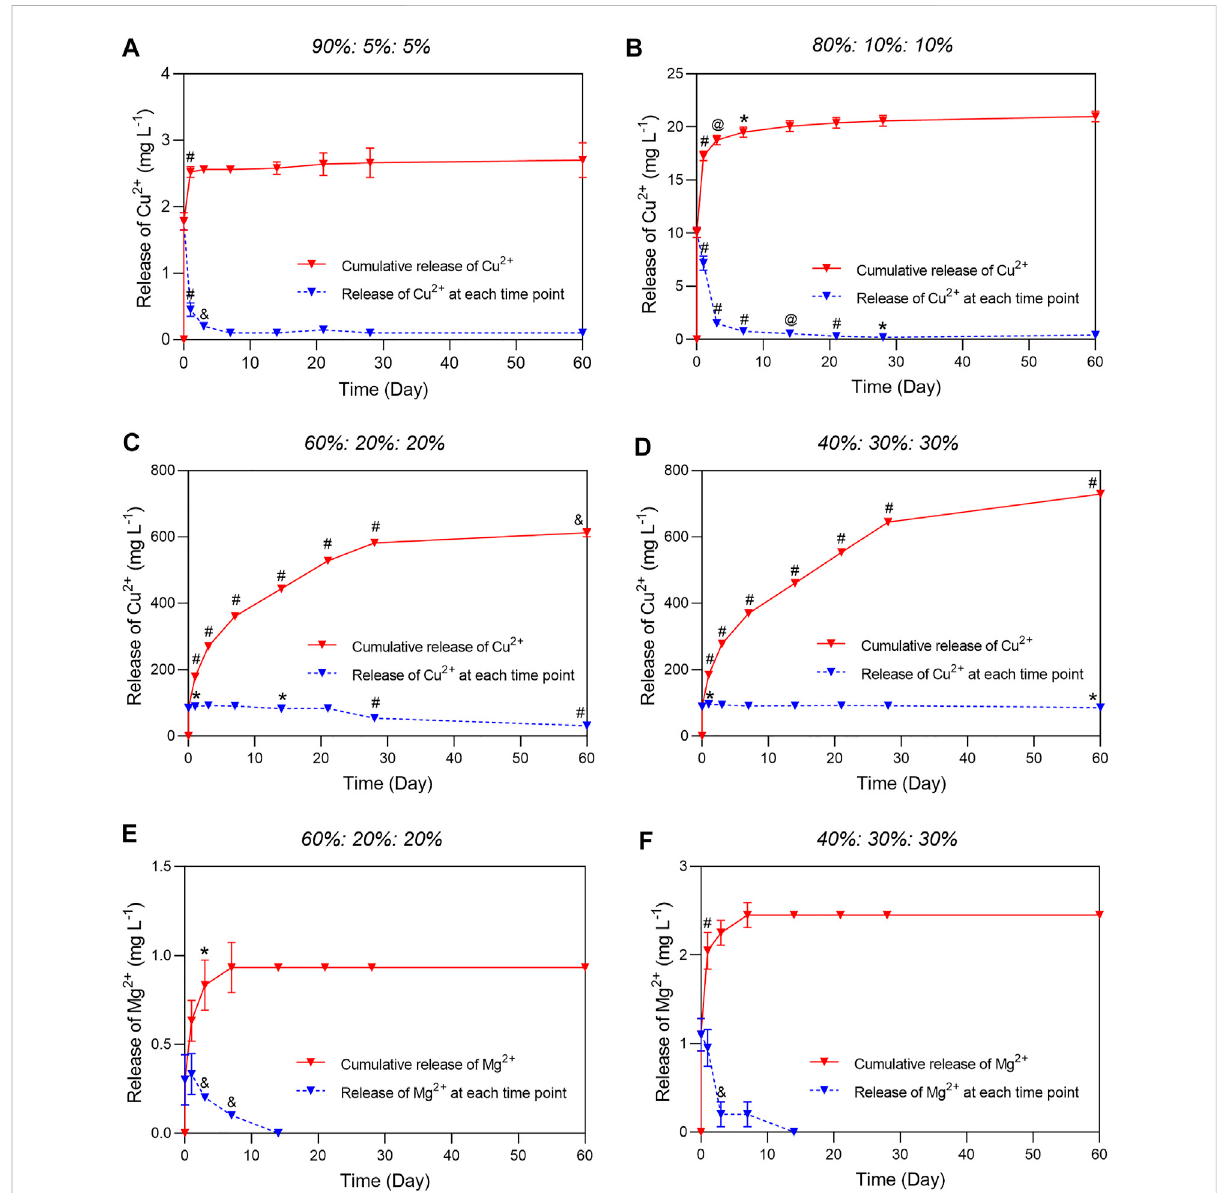
FIGURE 5 Ions release pro fi le of CaCuMg-PEM-Col microcapsules determined by ICP-OES. The concentration of Cu 2+ released from